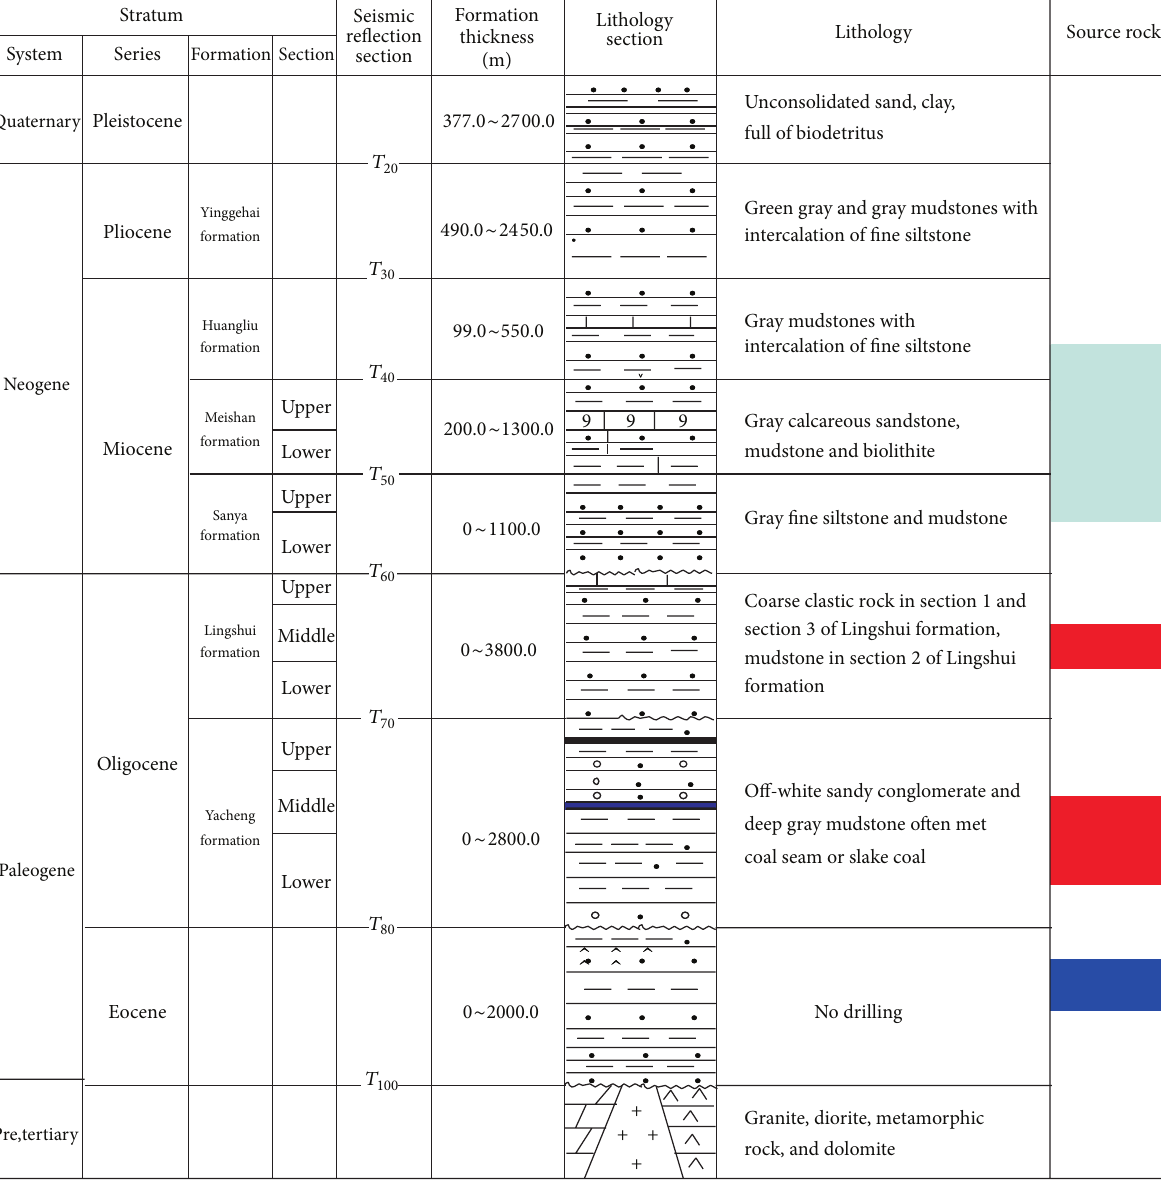
Figure 2: Comprehensive stratigraphic column of the Qiongdongnan Basin. Source rocks are marked with